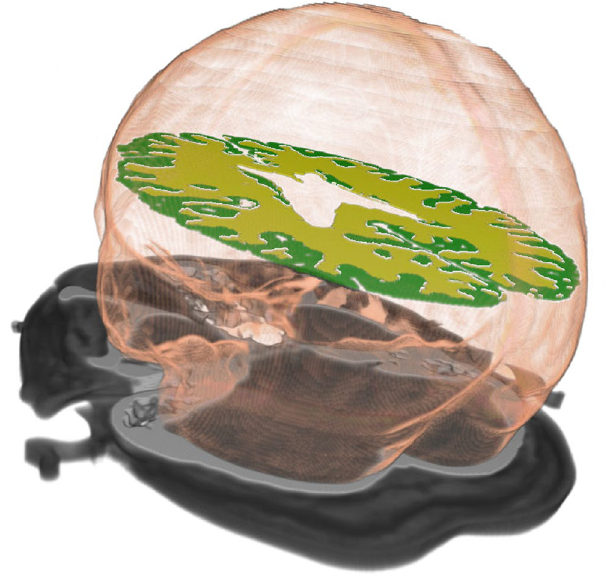
Figure 3. Volume rendering of the intracranial, WM and GM segmentations in 4D